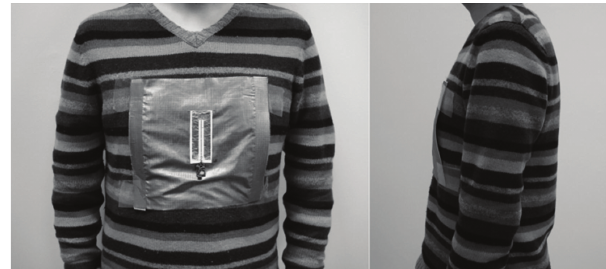
Figure 21: Proposed folded microstrip antenna worn on human body.